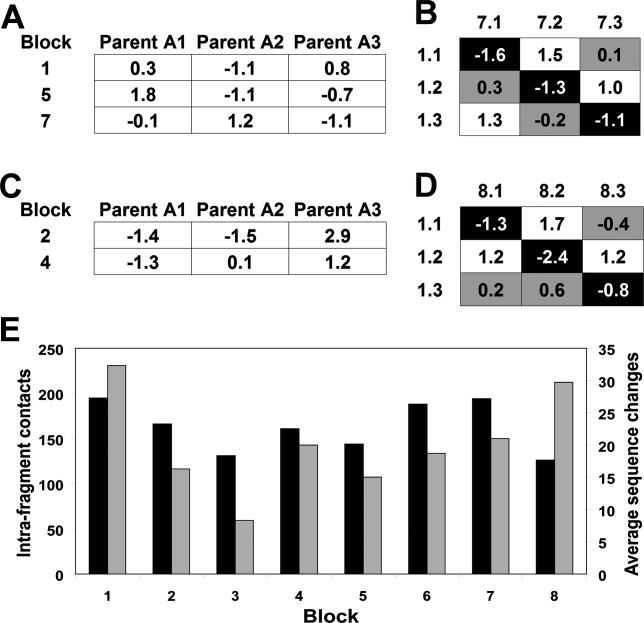
LRA of MSAs Identified Blocks and Block Pairs That Contribute to Whether a Chimera Folds and Binds Heme and Whether It Exhibits Activity on 12-pNCA(A) Intra-fragment terms in the energy model from LRA of folded/not-folded sequences indicate that blocks 1, 5, and 7 make significant contributions to folding and incorporation of heme. Negative energies increase the likelihood of folding and correctly binding heme while positive ones decrease it.(B) The single significant inter-fragment interaction from LRA of folded/not-folded sequences comes from pair 1–7 and includes the nine energy terms for pair 1–7, which can be divided into three groups. The on-diagonal elements (filled black) are the most stabilizing. The three terms filled gray have roughly average energy. The three white elements are destabilizing relative to the others.(C) Significant intra-fragment terms from LRA of the MSA of active/not-active sequences indicate that blocks 2 and 4 have significant effects on peroxygenase activity.(D) The single significant inter-fragment interaction between blocks 1 and 8, showing the nine terms, divided into similar groups as in part B.(E) Black bars, intra-fragment contacts within each block, as defined by the SCHEMA distance of 4.5 Å [
16]. Gray bars, the average number of sequence changes between each parent.